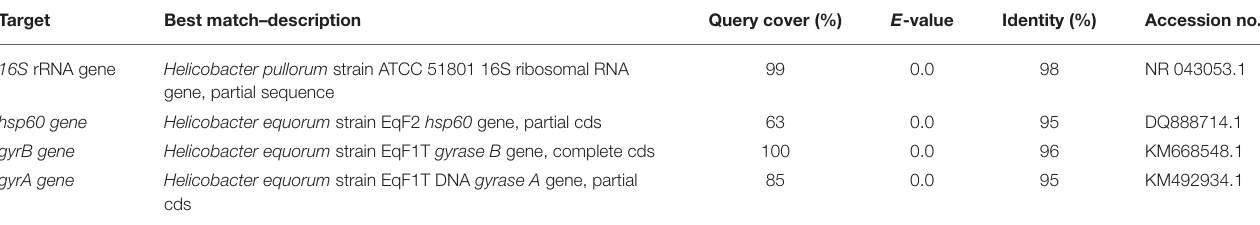
TABLE 1 | Best BLAST hits for the target genes used in the present study. Target Best